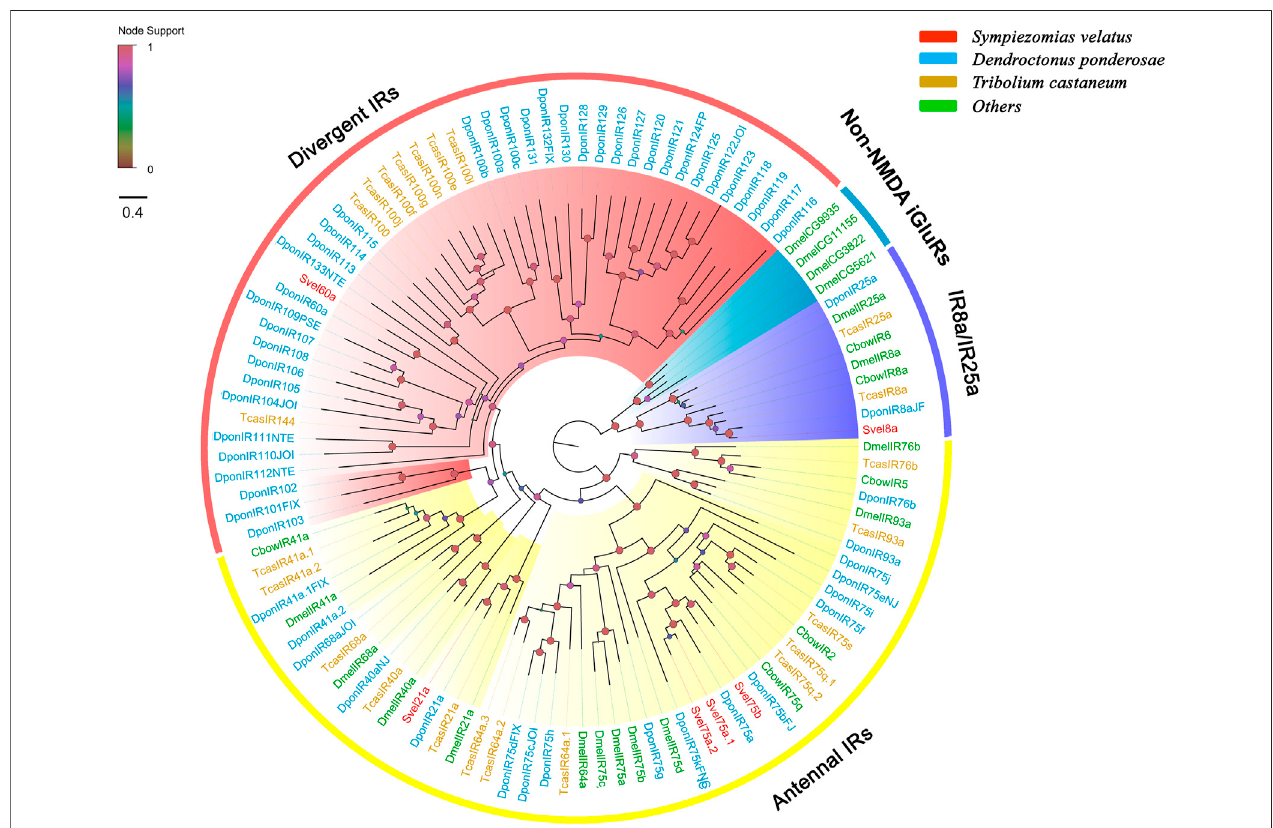
FIGURE 5 | Phylogenetic tree of the candidate ionotropic receptors (IRs) rooted with the conserved lineages of IR8a and IR25a proteins. The IR sequences included were from Sympiezomias velatus (Svel, red), Dendroctonus ponderosae (Dpon, blue), Tribolium castaneum (Tcas, yellow) and other species (green), including Drosophila melanogaster (Dmel, green) and Colaphellus bowringi (Cbow). The tree was constructed using FastTree based on a MAFFT alignment. The local support values based on the Shimodaira-Hasegawa (SH) test are indicated by the colored circles and increase with the brightness and size of the circles.